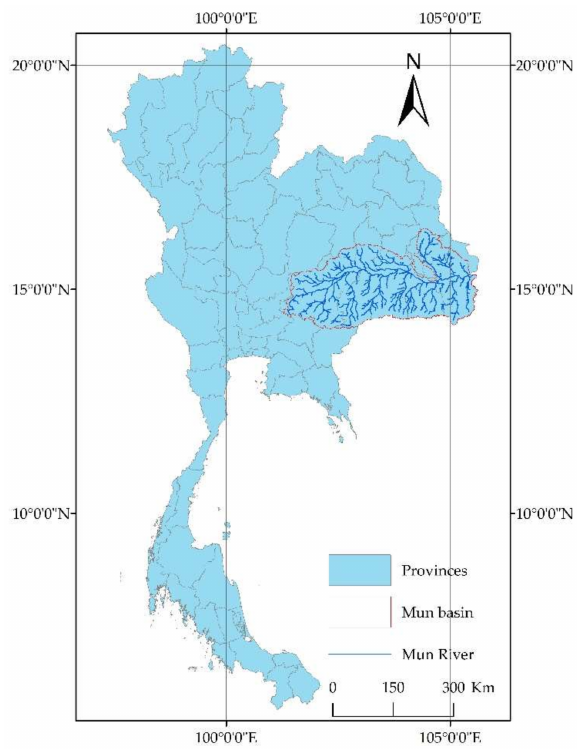
Figure 1. Location of Mun River